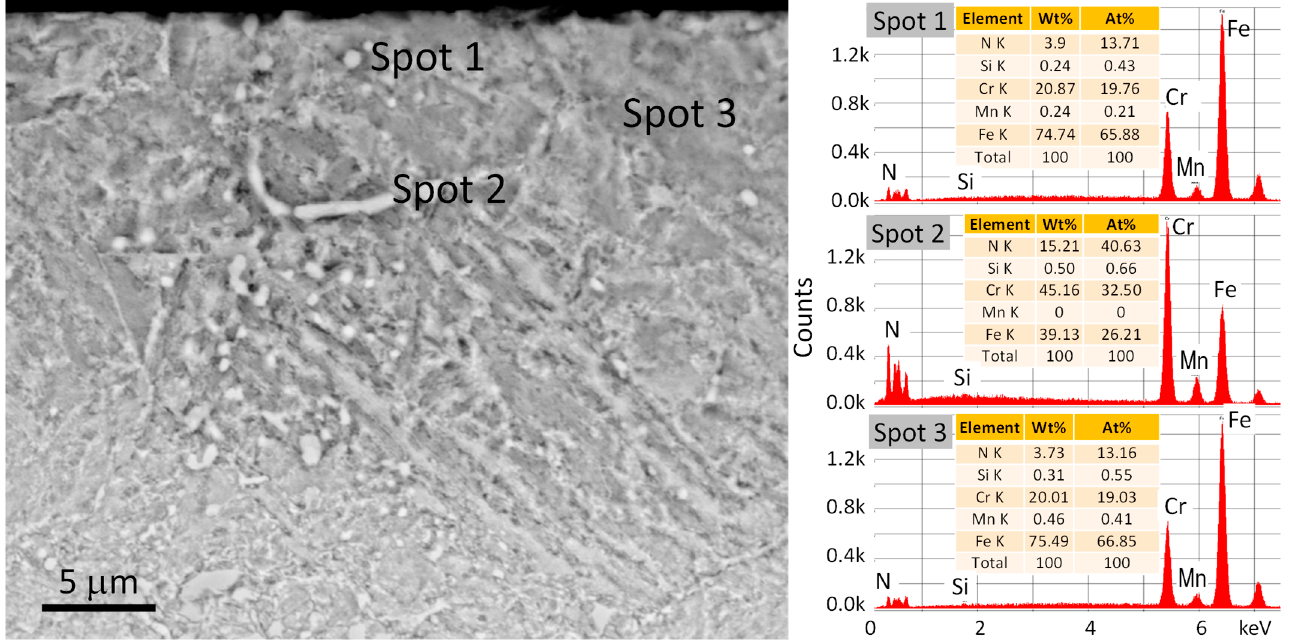
Figure 3. The SEM image of the nitrided zone of the (S) sample with the EDX spectra taken in three characteristic locations of the layer: Spot 1—close to a precipitate in the near-surface region inside the grain, Spot 2—a grain boundary precipitation, Spot 3—the grain volume at a slightly deeper region below the surface.